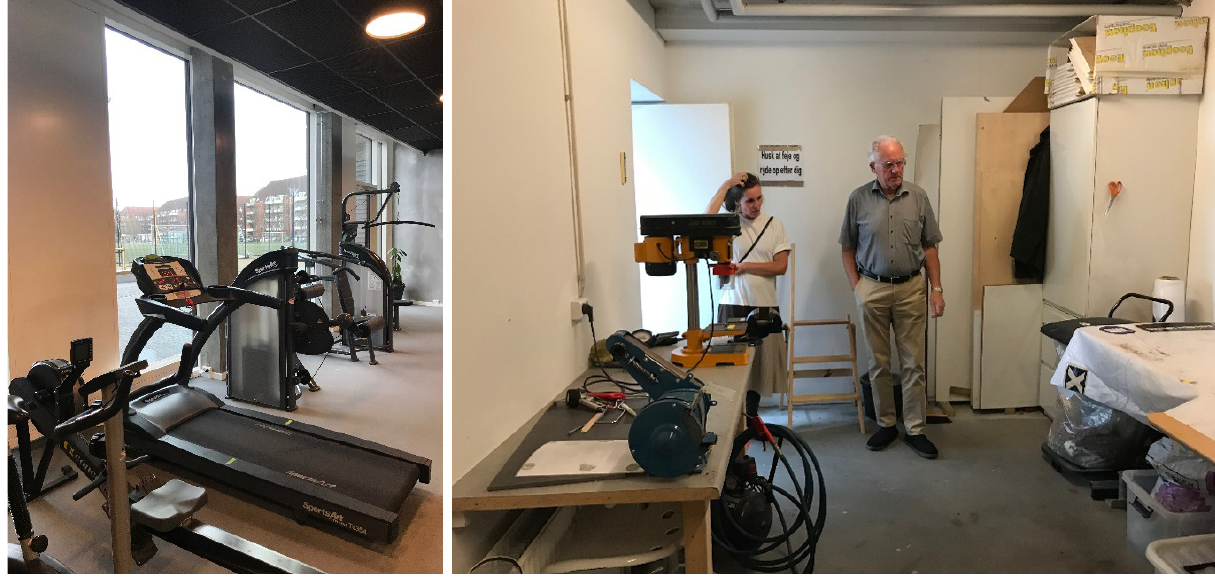
Figure 3. Housing support functions. A fitness room in Nordbro, Copenhagen (left) and a workshop for senior residents at the Silhouette, Løgten (right). Housing support facilities can be used individually, but they also invite residents to interact due to the need for common usage guidelines. Source: Mechlenborg and Hauxner (2021, p.